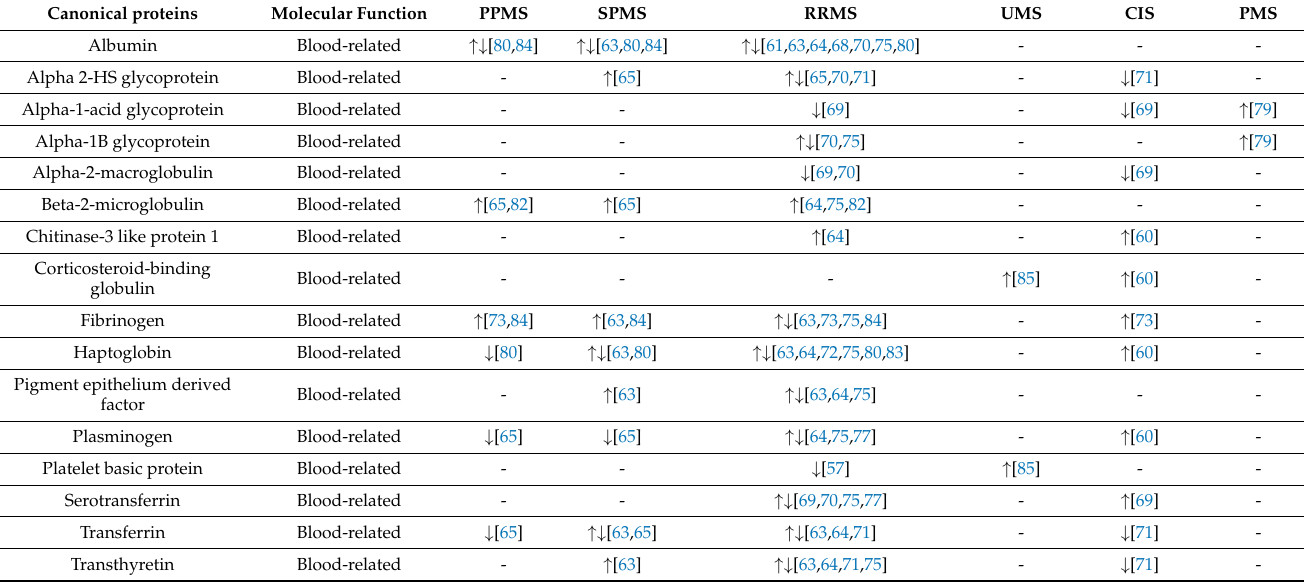
Table 4. Changes in canonical proteins in different subtypes of